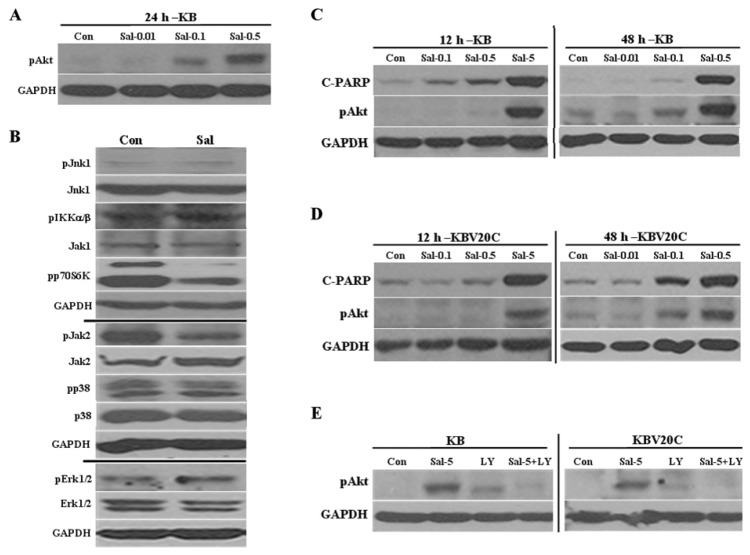
The Sal-mediated Akt activation is conserved in other cell lines. (A) KB cell extracts were collected 24 h after treatment with 0.01 μM Sal (Sal-0.01), 0.1 μM Sal (Sal-0.1), 0.5 μM Sal (Sal-0.5), or DMSO-treated (Con). Western blot analyses were performed using antibodies against pAkt and GAPDH. (B) KB cell extracts were collected 24 h after treatment with 0.5 μM Sal (Sal) or from untreated samples (Con). Western blot analyses were performed using antibodies against pJnk1, Jnk1, pErk1/2, Erk1/2, p38, pp38, pJak2, Jak1, Jak2, pIKKα/β, pp70S6K, and GAPDH. (C,D) KB and KBV20C cells were plated on 6-well plates and grown to 30%–40% confluence. The cells were then stimulated for 12 or 48 h with 0.01 μM Sal (Sal-0.01), 0.1 μM Sal (Sal-0.1), 0.5 μM Sal (Sal-0.5), 5 μM Sal (Sal-5), or DMSO (Con). The cells were used for western blot analysis using antibodies against C-PARP, pAkt, and GAPDH. (E) KB and KBV20C cells were plated on 6-well plates and grown to 30%–40% confluence. The cells were then stimulated for 24 h with 5 μM Sal (Sal-5), 20 μM LY294002 (LY), 5 μM Sal with 20 μM LY294002 Sal-5 + LY), or DMSO (Con). The cells were used for western blot analysis using antibodies against pAkt and GAPDH.